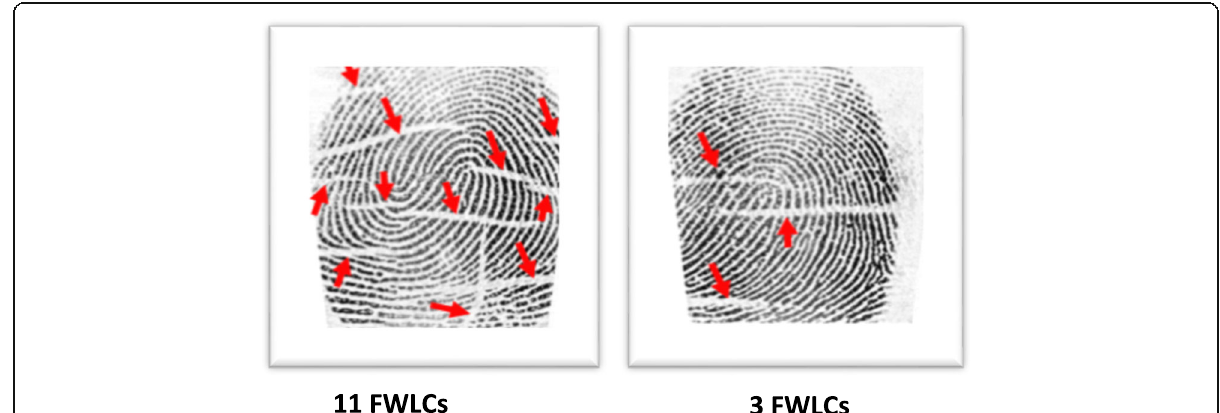
Fig. 1 Techniques for fingerprints white line counts